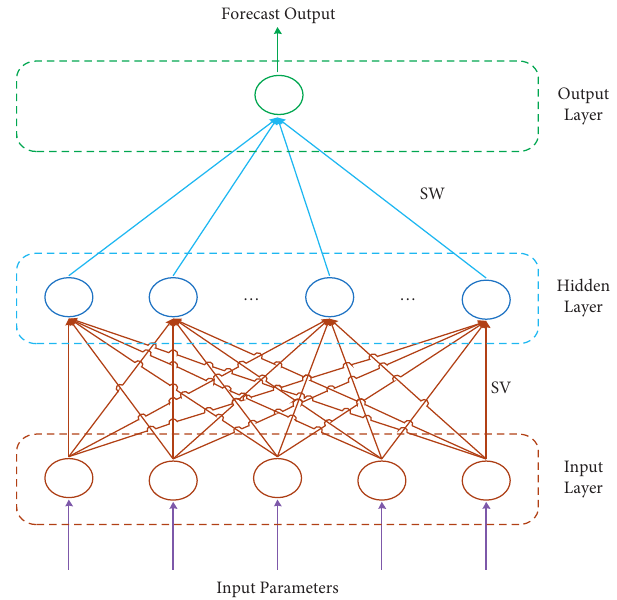
Figure 3: Structural design of the proposed MLPNN. Table 3: Designed parameters of the proposed various artificial neural